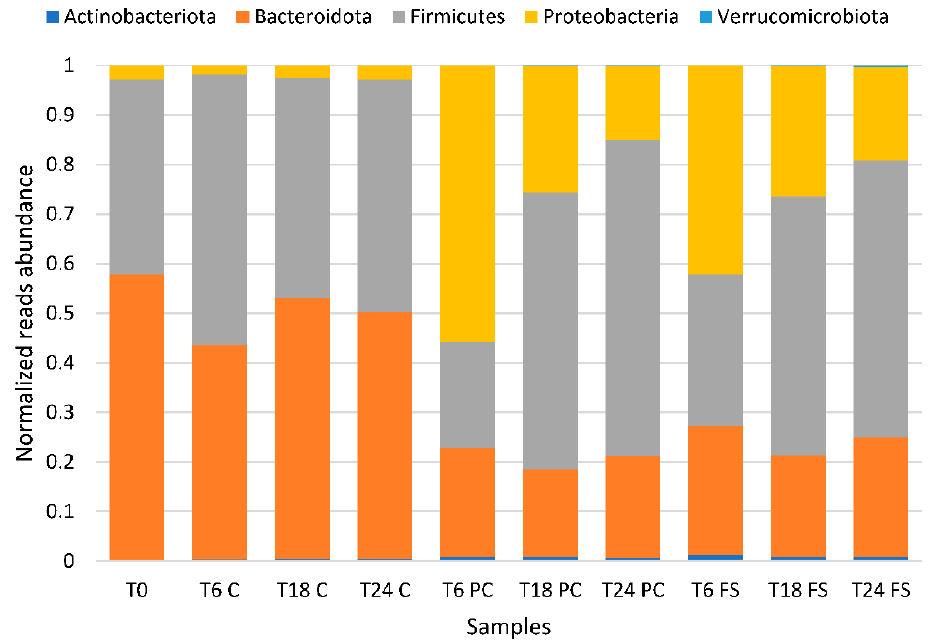
Figure 3. Stacked bar plot of the relative abundance of phyla present in human gut microbiota batch cultures. T0, T6, T18, T24 = observed timepoints 0 h, 6 h, 18 h, and 24 h; C = control fermentation